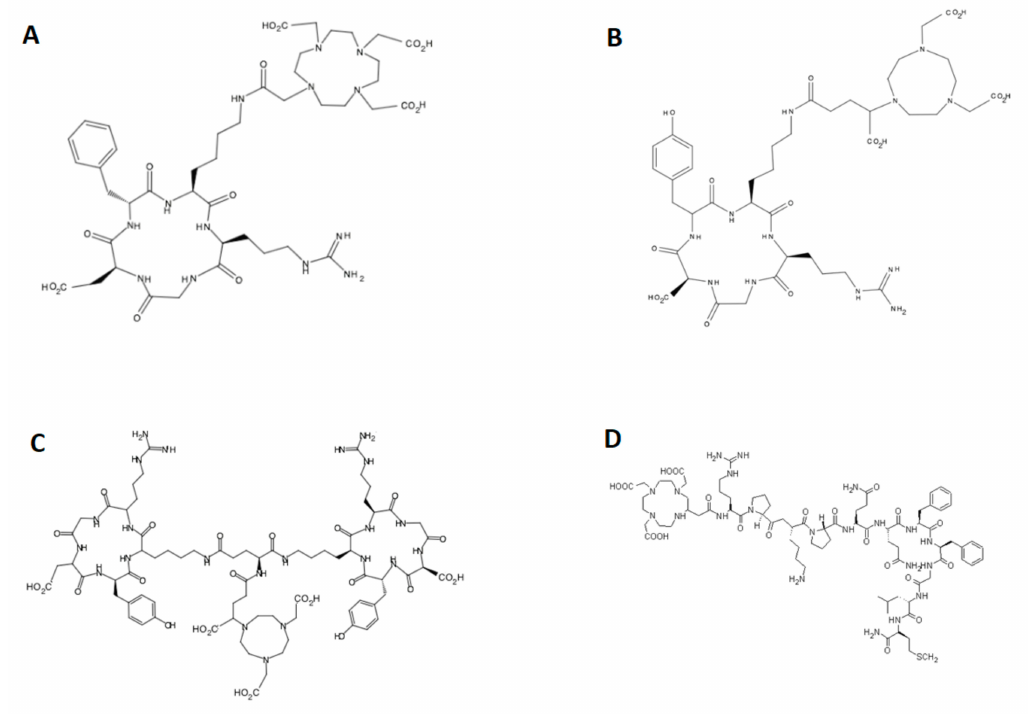
Figure 5. The chemical structures of tested peptides coupled with respective chelators. ( A ) DOTA- c(RGDfK), ( B ) NODAGA-c(RGDyK), ( C ) NODAGA-c(RGDyK) 2 , and ( D ) DOTA-substance